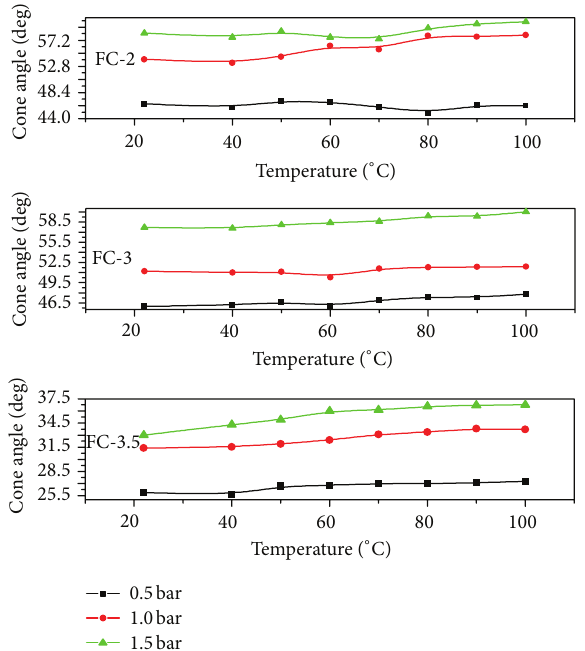
Figure 5: Spray cone angle as a function of